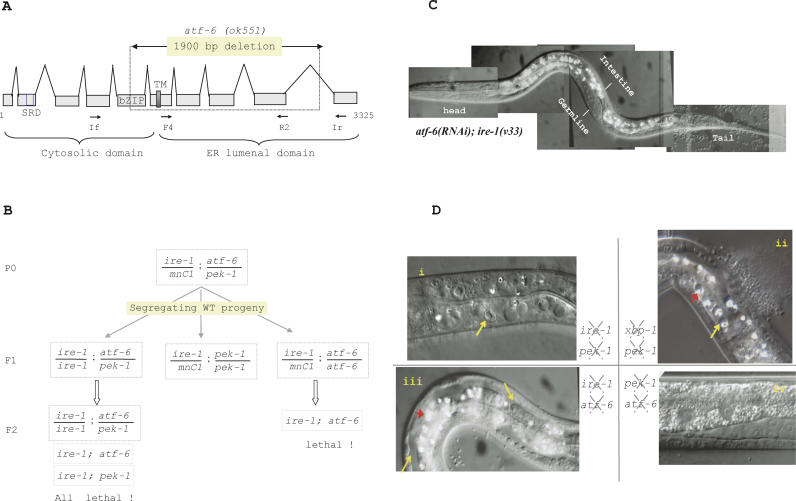

C. elegans atf-6 and pek-1 Display Partially Redundant Roles in Complementing ire-1/xbp-1 for Larval Survival and Development(A) Characterization of C. elegans atf-6 and its ok551 deletion allele. The atf-6 gene structure is depicted in boxes and lines, representing exons and introns, respectively. The atf-6(ok551) allele lacks 1,900 bp of genomic sequence, and has the potential to encode a protein without the leucine zipper portion of the bZIP domain, the transmembrane domain, and ER lumenal domain. The atf-6(ok551) deletion allele can be detected by PCR, using the primers indicated by arrows.(B) Genetic interactions of atf-6, ire-1, and pek-1. Animals with the genotype ire-1(v33); atf-6(ok551) arrested as young larvae, showing that loss of both ire-1 and atf-6 is lethal. The ire-1(v33)/ mnC1; atf-6(ok551)/ pek-1(ok275) animals (P0) segregated healthy F1 progeny with the genotype ire-1(v33); atf-6(ok551)/ pek-1(ok275), which in turn produced dead F2 animals with exactly the same genotype, suggesting that ATF-6 and PEK-1 function synergistically to cope with endogenous ER stress during development.(C) Nomarski micrograph of a 3-d-old atf-6(RNAi); ire-1(v33) animal. The germline of this animal did not develop past the L2 larval stage.(D) Comparisons of intestinal degeneration in various double mutants: (i) ire-1(v33); pek-1(ok275), (ii) xbp-1(RNAi); pek-1(ok275), (iii) ire-1(v33); atf-6(RNAi), and (iv) atf-6(RNAi); pek-1(ok275). Normaski micrographs show a portion of the intestine. Mutants in (i)–(iii) arrested at the L2 larval stage and showed intestinal degeneration. The mutants in (iv) had an intestinal morphology similar to the wild-type. Yellow arrows indicate vacuoles in intestinal cells. Red arrowheads indicate light-reflective aggregates appearing in some mutants ([ii]and [iii]).